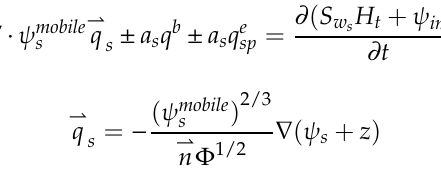
Figure S1: (a) Sediment erosion (negative value) and deposition (positive value) rates for Shejiagou catchment; (b) Sediment inflow to stream segments; (c) Cumulative flow without check dams (Debasish et al., 2018), Figure S2. Open check dams. Beam dam (left), silt dam (right). Derived from Armanini and Larcher (2001), Figure S3. Characteristic components of a sediment trap with an open check dam: (a) inlet structure: solid body dam; (b) scour protection; (c) basin; (d) lateral dikes; (e) maintenance access; (f) open check dam; (g) counter